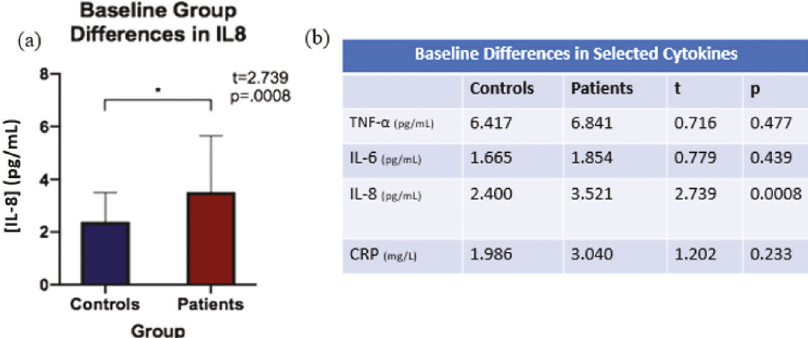
Fig. 2 Baseline Cytokine Group Comparison. a Patient/control group baseline differences in IL-8 (error bars represent s.d.); b Patient/control Group differences at baseline in selected cytokines.